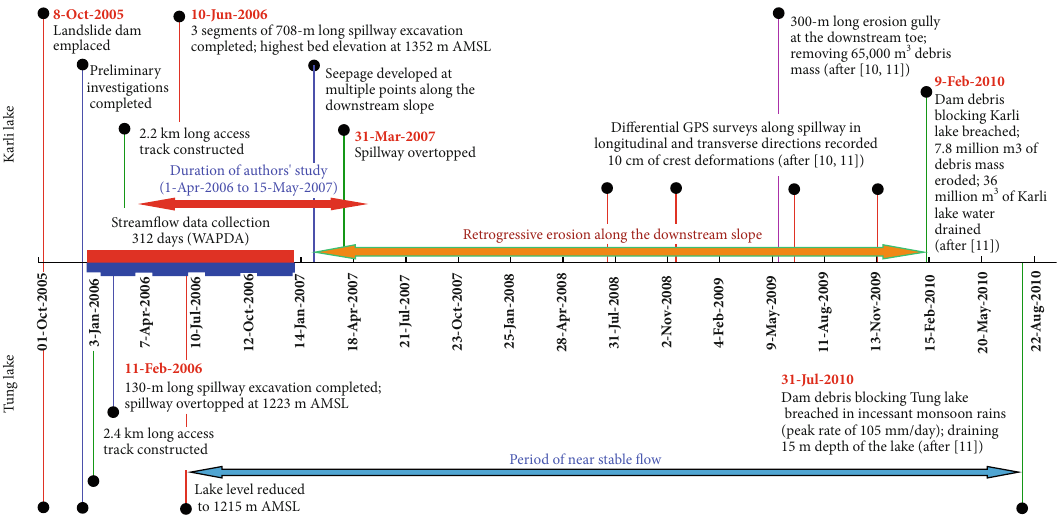
Figure 4: Chronology of events that occurred at the Hattian Bala landslide dam site from its creation to its breach (October 8, 2005, to July 31,